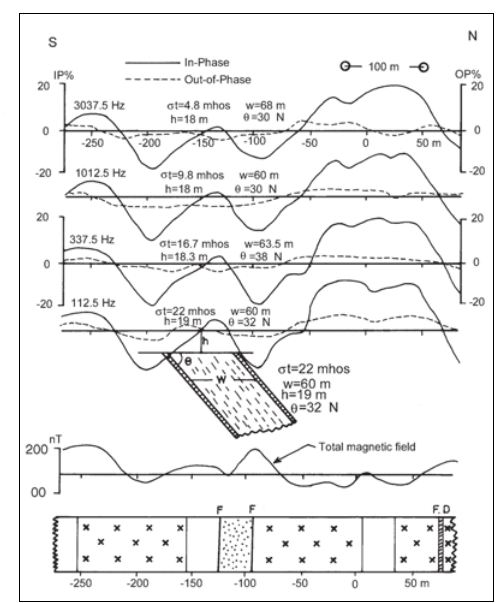
Fig. 9. Horizontal-loop EM profiles at several fre- quencies, coil separations and station separations with the corresponding total magnetic field profile along line B-B ′ (line 300) and surface geology of the Abu- Shihat radioactive prospect area, North Eastern Desert, Egypt. Symbols as in fig. 2.